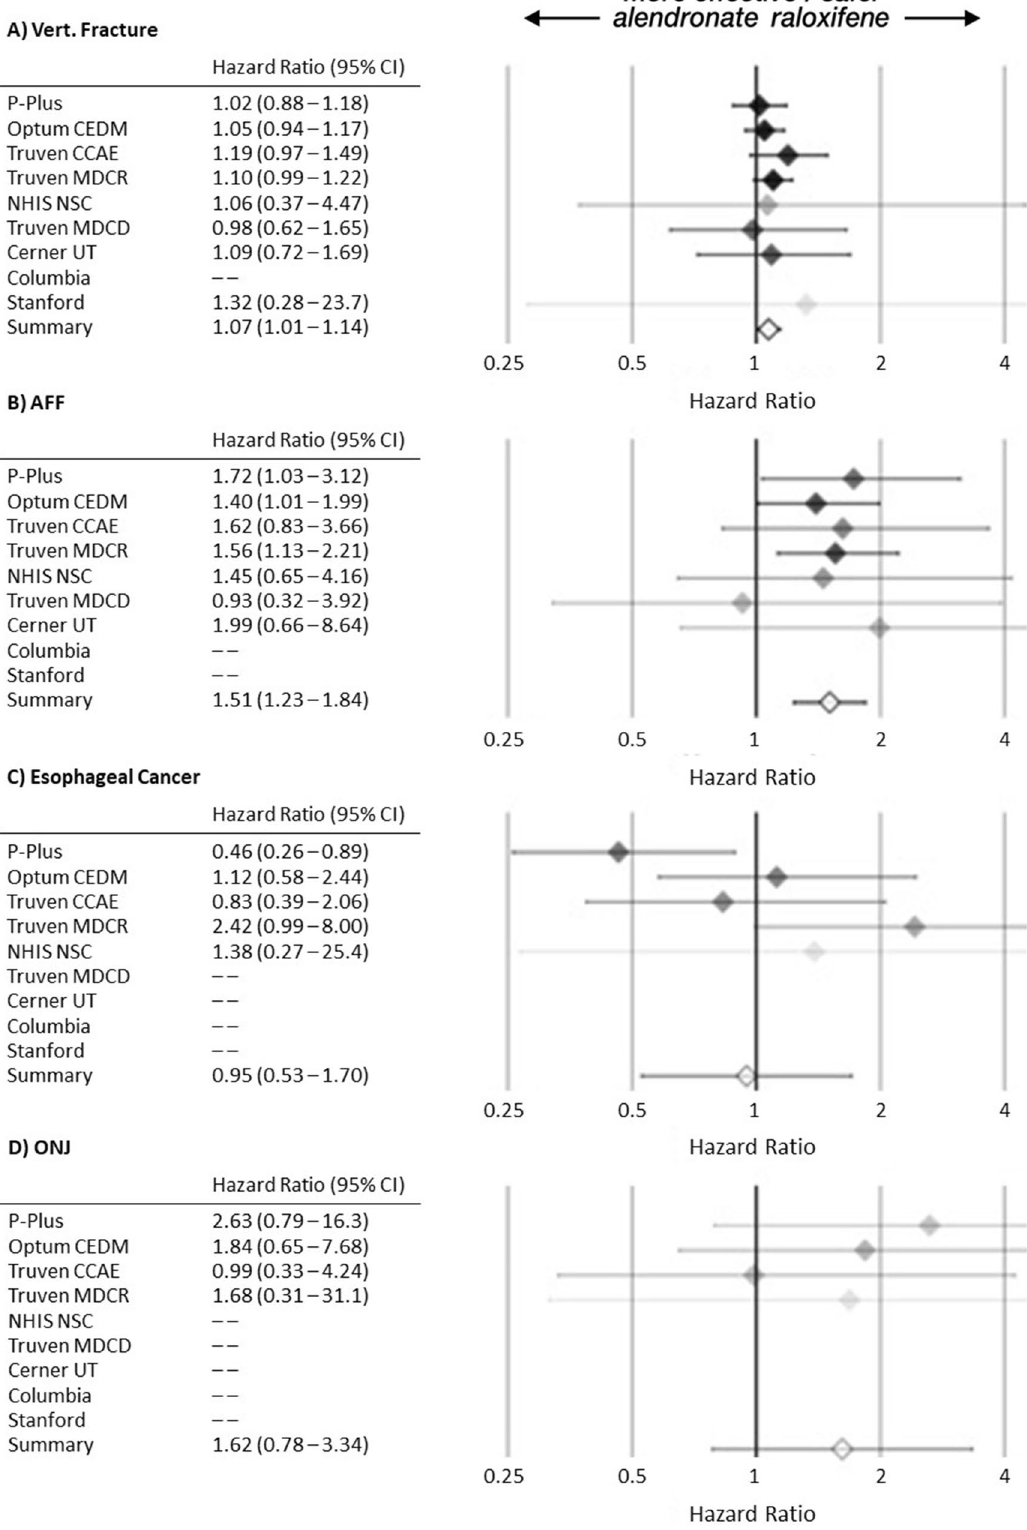
Fig. 2. Primary analysis hazard ratios for ( A ) vertebral fracture (Vert. Fracture), ( B ) atypical femoral fracture (AFF), ( C ) esophageal cancer (Eso. Cancer), and ( D ) osteonecrosis of jaw (ONJ). More precise estimates have greater opacity. Missing HR from data sources with 0 raloxifene